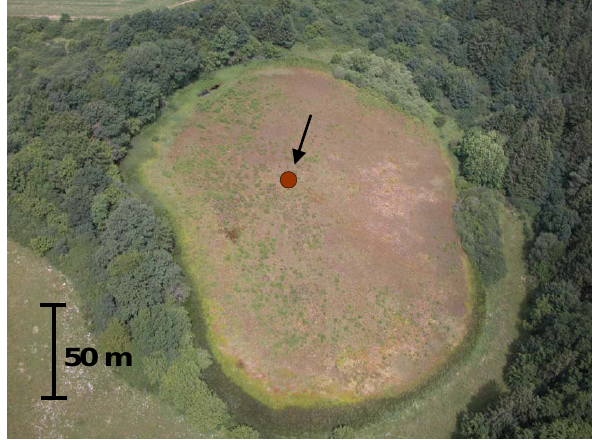
Fig. 2. Aerial photograph of D¨urres Maar with borehole